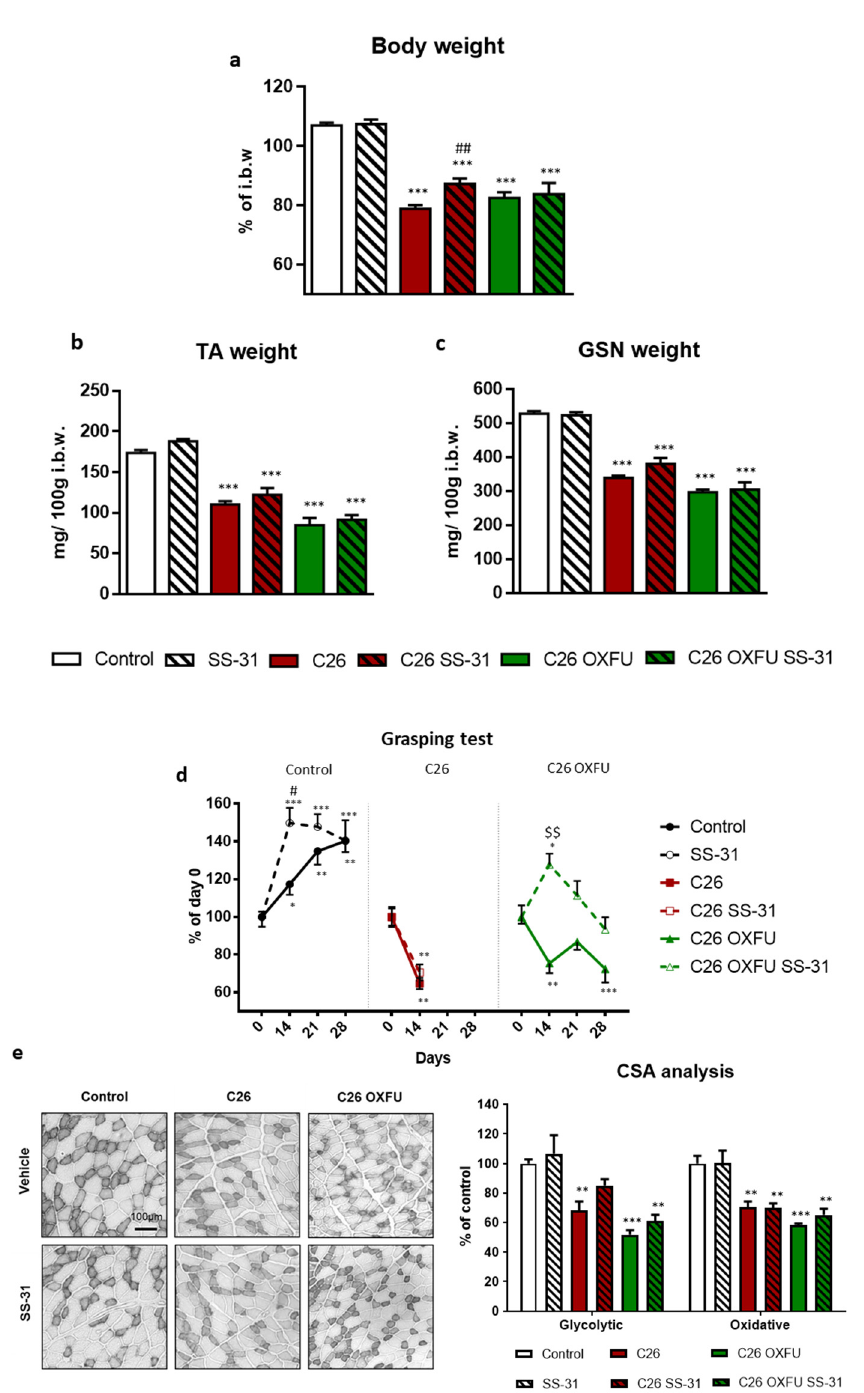
Figure 1. SS-31 slightly impacts on cancer- and chemotherapy-induced cachexia. Body weight ( a ), tibialis anterior weight (TA; b ), gastrocnemius weight (GSN; c ), grasping test ( d ) and cross sectional area (CSA; e ; representative pictures and quantification) of glycolytic and oxidative (light and dark grey, respectively) muscle fibers of controls ( n = 7), SS-31-treated mice (SS-31; n = 6), tumor-bearing mice (C26; n = 8), SS-31-treated tumor-bearing mice (C26 SS-31; n = 8) and tumor-bearing mice administered with chemotherapy alone (C26 OXFU; n = 8) or in combination with SS-31 (C26 OXFU SS-31; n = 8). Body weight data (means ± SEM) are expressed as percentage of initial body weight (i.b.w.). Muscle weight (means ± SEM) is expressed as mg of tissue per 100 g of initial body weight. Grasping test data (means ± SEM) are expressed as percentage of day 0. CSA (means ± SEM) is expressed as percentage of control. Significance of the differences: ** p < 0.01, *** p < 0.001 vs. control; ## p < 0.01 vs. C26. For grasping test (panel d) the significance of the difference is * p < 0.05, ** p < 0.01, *** p < 0.001 vs. day 0; # p < 0.05 vs. control; $$ p < 0.01 vs. C26 OXFU.